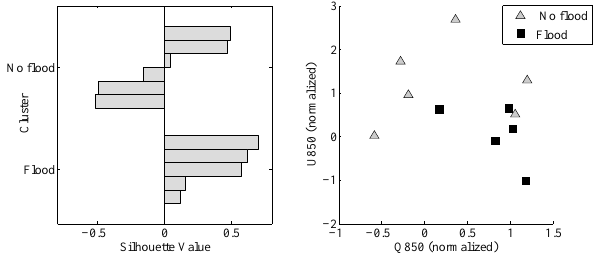
Figure 3. A worked example of calculating SI values. The right- hand panel plots the specific humidity at 850hPa and U wind at 850hPa for five flood days and six non-flood days. These values were then used to derive the individual silhouette values in the plot on the